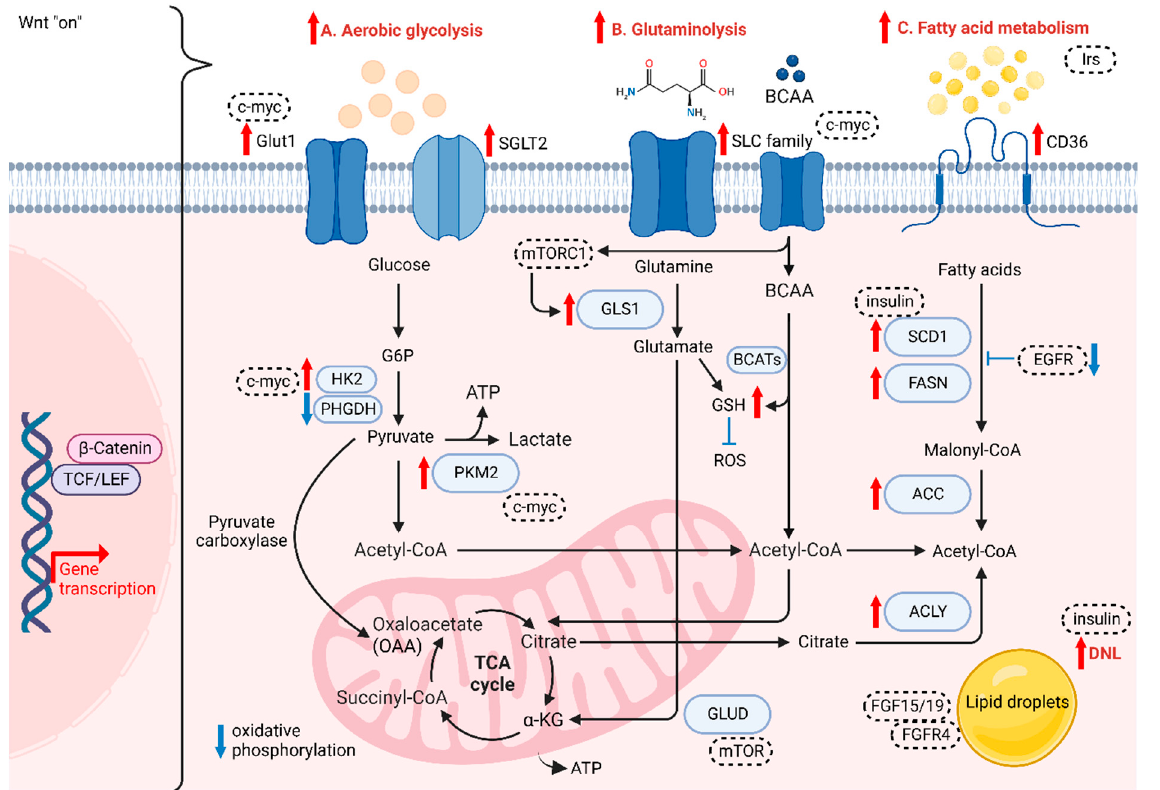
Figure 2. The role of Wnt/ β -catenin signaling on cancer metabolism. Wnt/ β -catenin plays crucial role in ( A ) aerobic glycolysis, ( B ) glutaminolysis and ( C ) fatty acid metabolism of HCC cells.